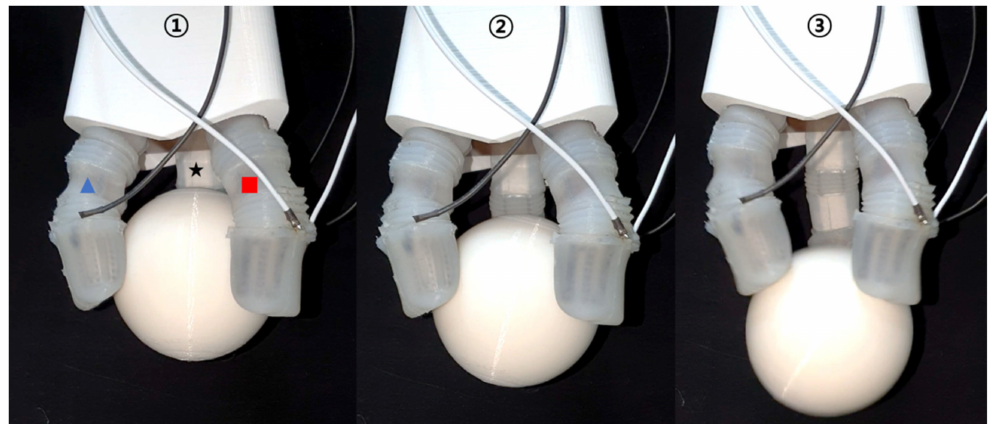
Figure 20. Images of a spherical object slipping from the gripper during characterization experiments. Labels in this image correspond to the timestamps in Figure 19.